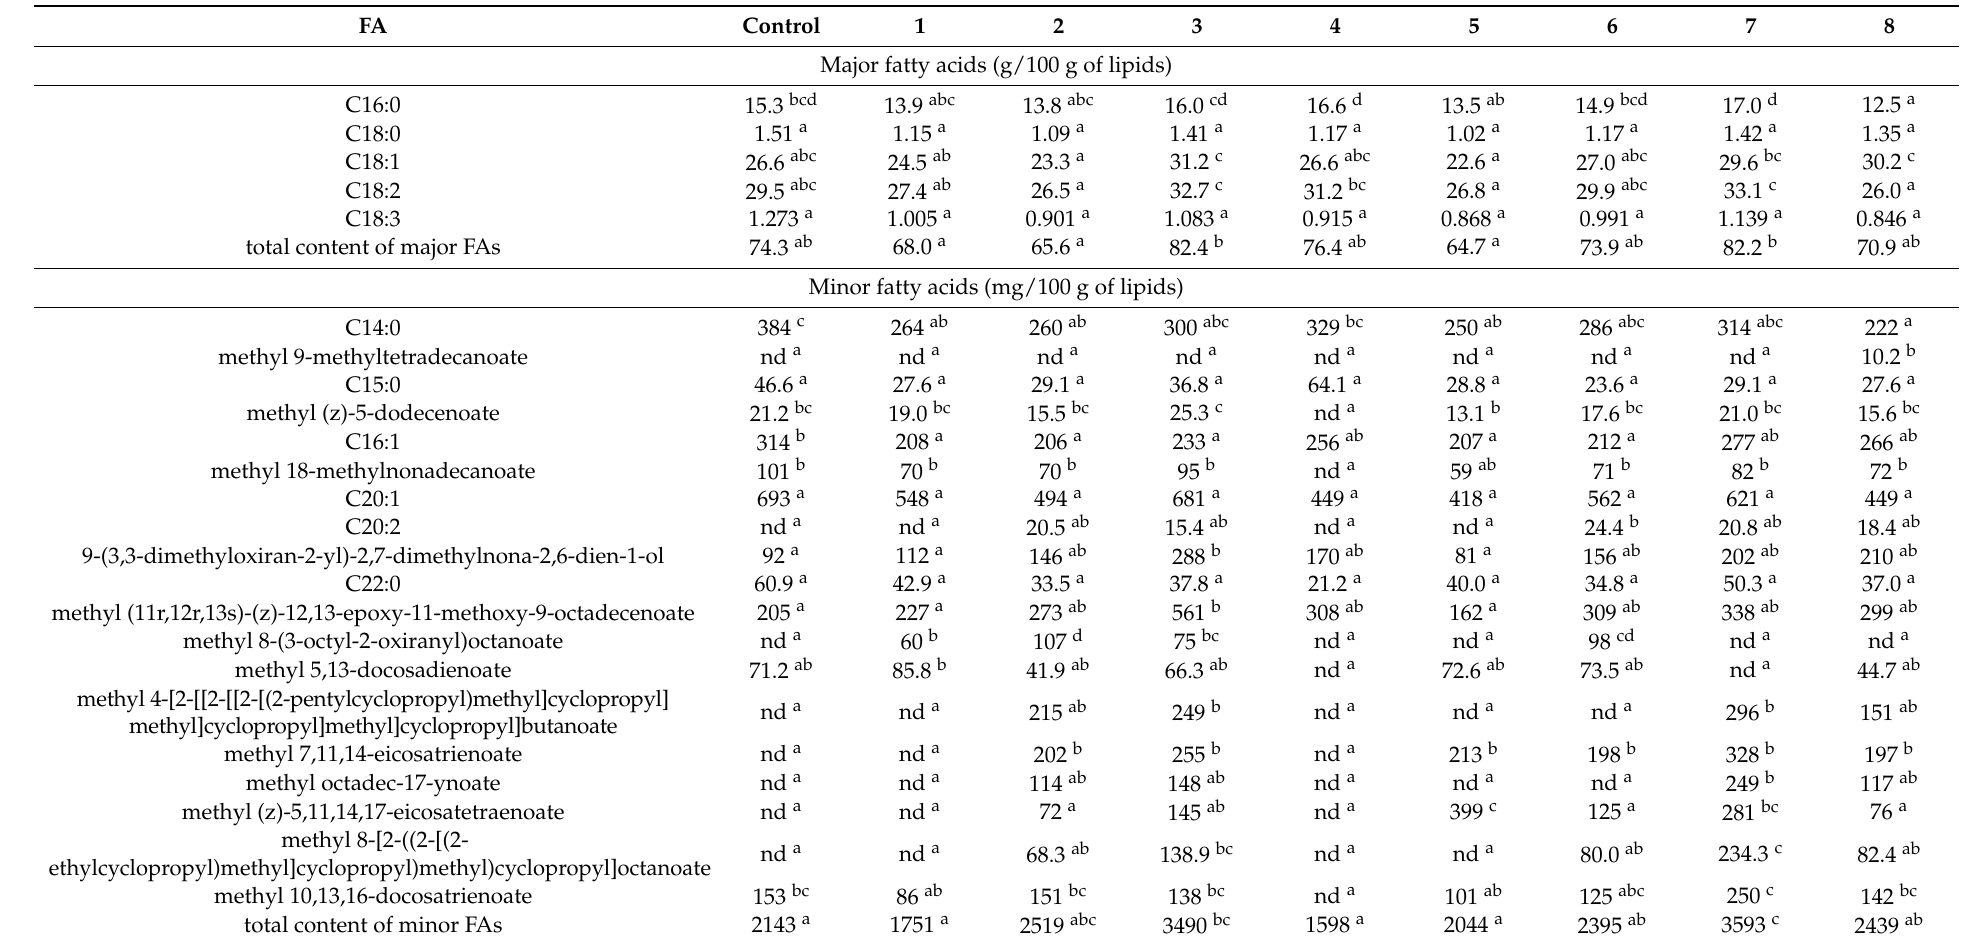
Table 3. Fatty acids content in the control and fermented (48 h) oat